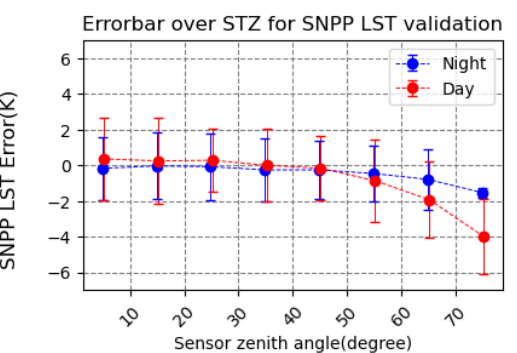
Figure 6. The relationship between the LST error and sensor view zenith angle over all six SURFRAD sites.